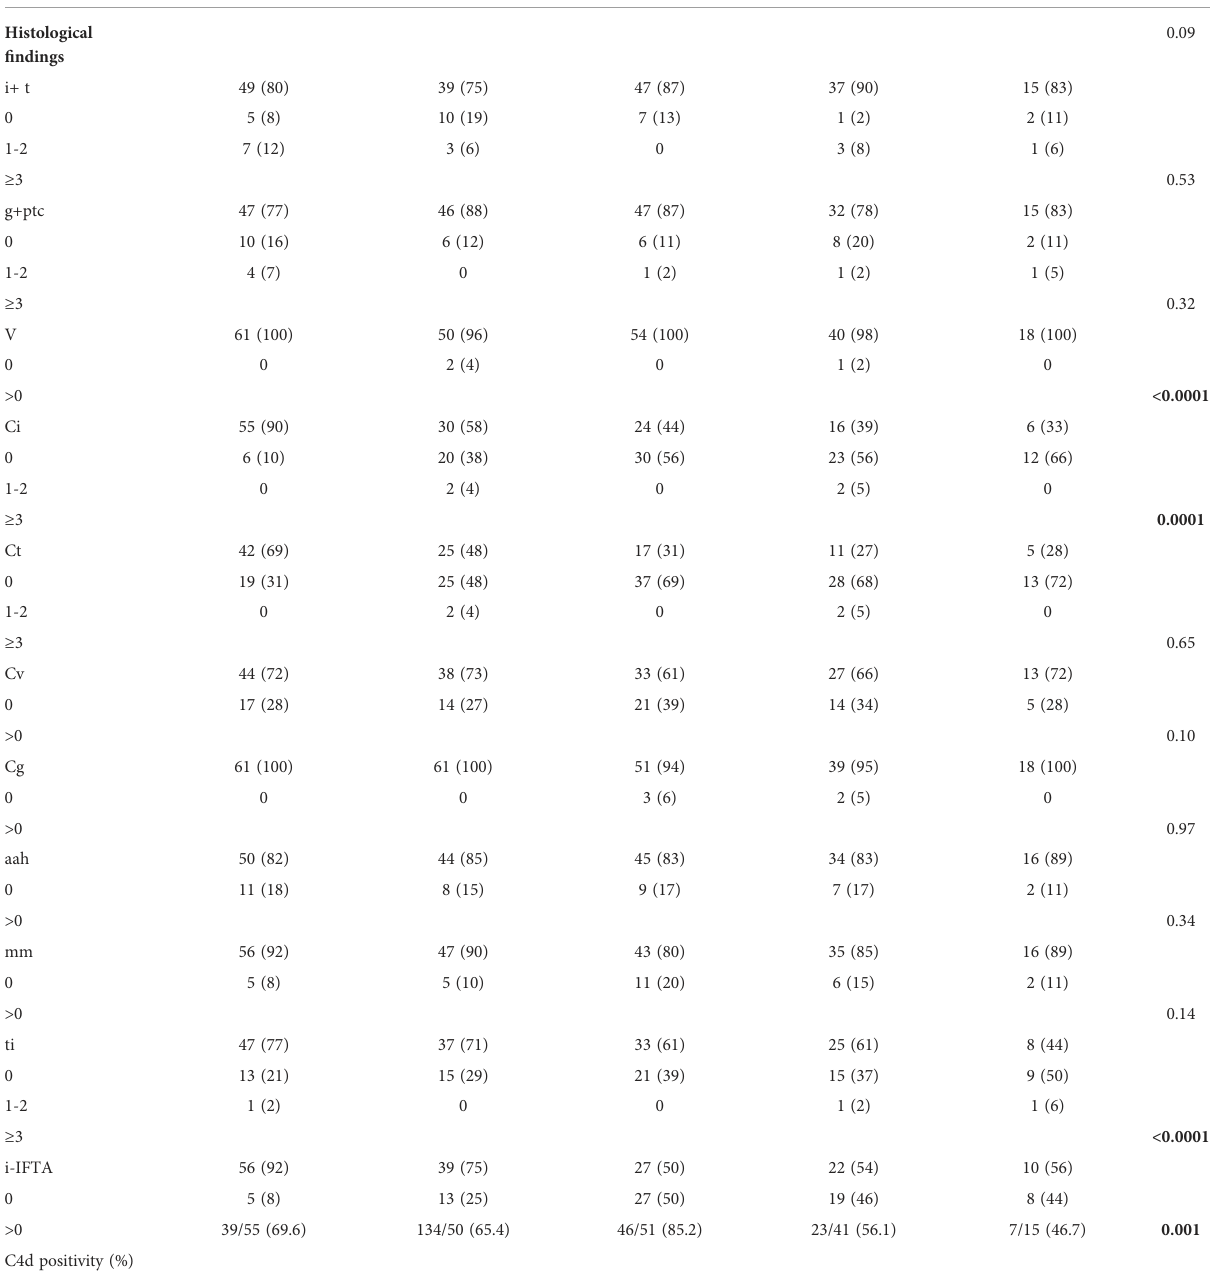
TABLE 2 Results offollow-up biopsies during the 5 years post transplantation after ABO incompatible kidney transplantation without preformed